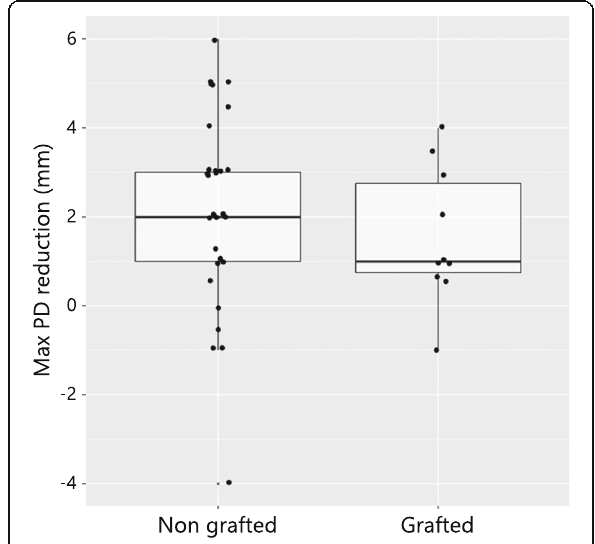
Fig. 5 Box plot illustrating maximum PD reduction between the grafted and non-grafted patient groups that did not reach a significant difference ( p =